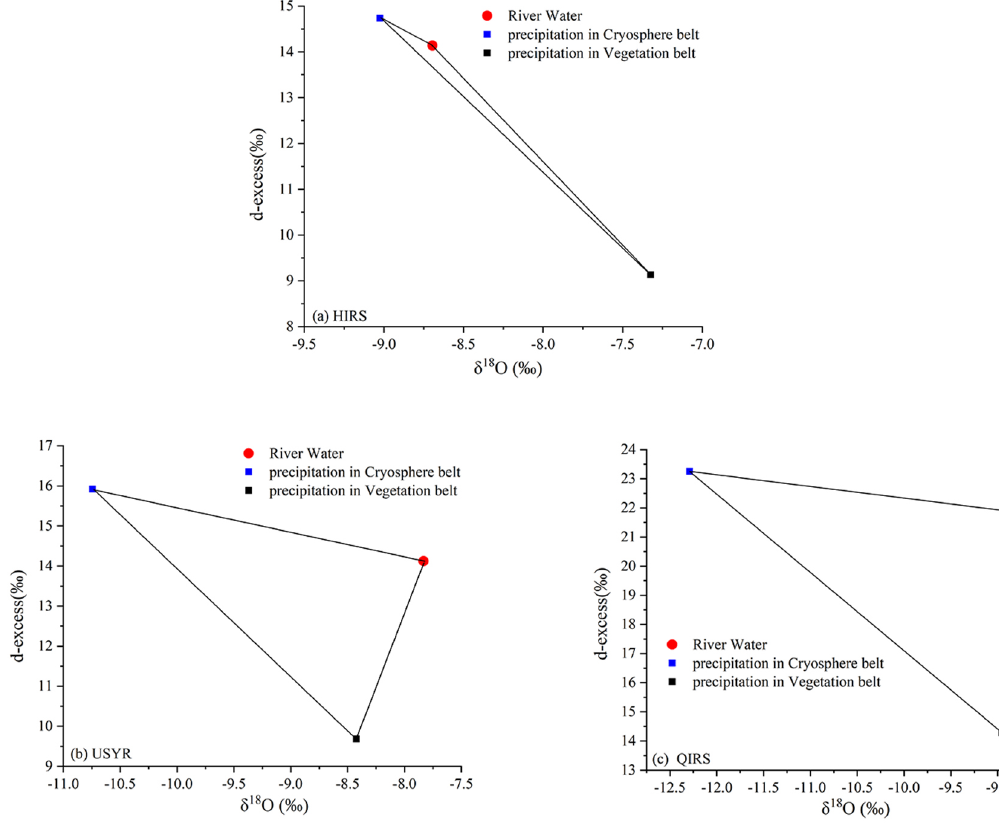
Figure 10. Mixing diagram using the mean δ 18 O and d-excess values for the outlet runoff in the (a) HIRS, (b) USYR, and (c)